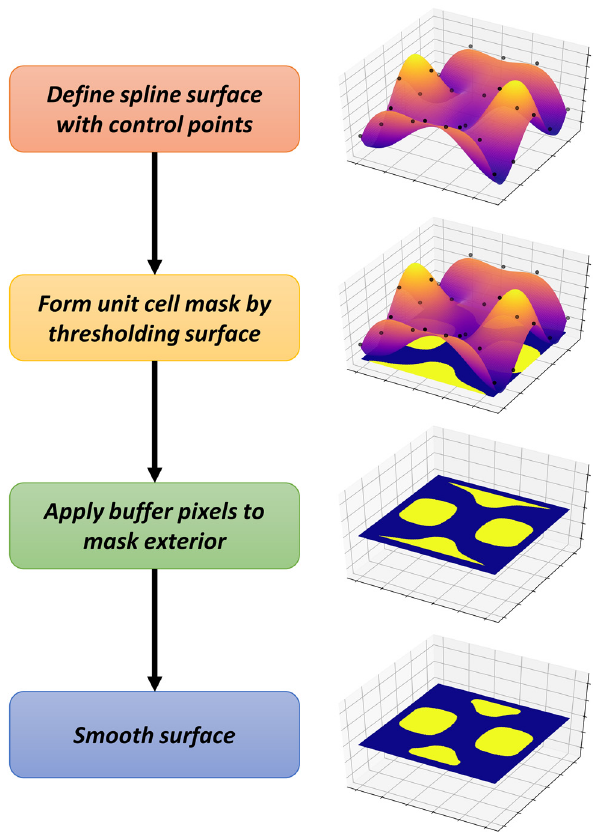
Figure 1: Process for creating unit masks using thresholding of spline surfaces, buffering, and MFS filtering. Each unit cell is assumed to be fourfold symmetric. After constructing these masks, the unit cells are combined together in sets of four to create